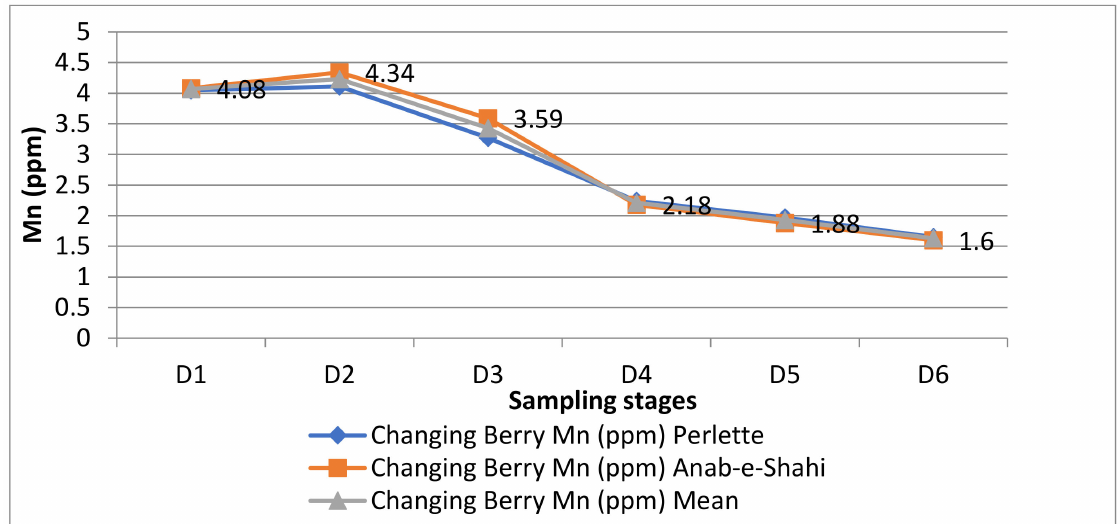
Figure 8. Change of Mn (ppm) during the development of berries in grapes cv. Perlette and Anab-e-Shahi.